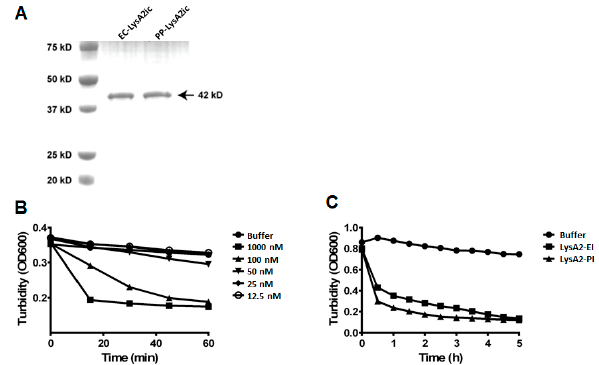
Figure 1. Purification and lytic activity of intracellularly expressed LysA2 from P. pastoris and E. coli . Intracellularly produced LysA2 from E. coli (LysA2-EI) and P. pastoris (LysA2-PI) were purified and confirmed by protein size and lytic activity. SDS-PAGE analysis shows LysA2-EI and LysA2-PI are approximately the expected size of 42 kDa ( A ). Lytic activity of LysA2-PI measured by turbidity reduction with L. casei . Lytic activity increased proportionally with increased protein concentration ( B ). Lytic activity of LysA2-PI (100 nM, 4.22 μ g/mL) was compared with LysA2-EI (100 nM, 4.22 μ g/mL) using turbidity reduction with L. casei ( C ). To measure the lytic activity of LysA2, the turbidity reduction of a suspension of L. casei was measured after application of the enzyme. Intracellularly produced LysA2 from P. pastoris showed dose-dependent lytic activity, and required concentrations greater than 50 nM to be detected (Figure 1B). The addition of LysA2 from E. coli and P. pastoris produced a comparable turbidity reduction of L. casei cells over five-hour span at the same dose (Figure 1C). This result indicates that LysA2 can be functionally expressed intracellularly in yeast, and the activity of this P. pastoris produced LysA2 is equivalent to that of the E. coli produced LysA2.